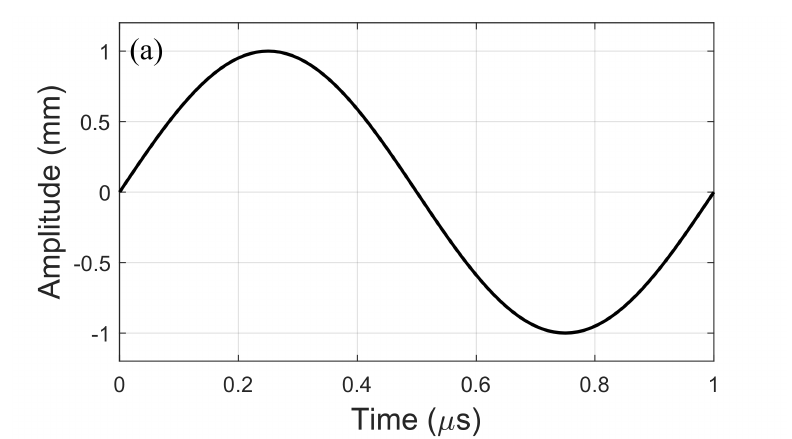
Figure 1. Intact steel rod model.